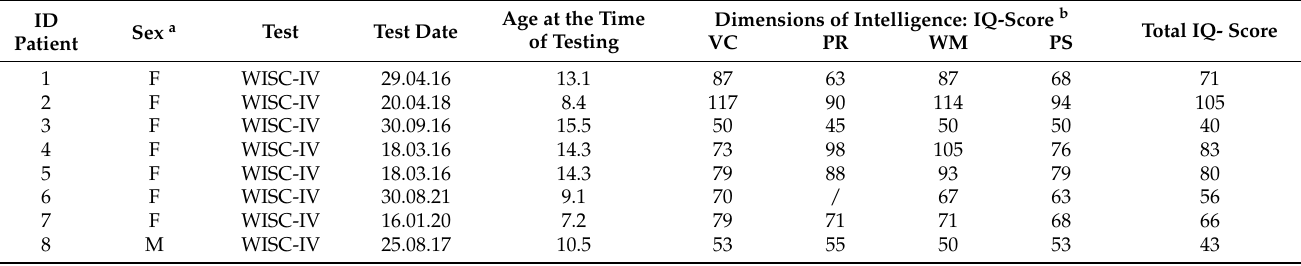
Table 2. Cognitive